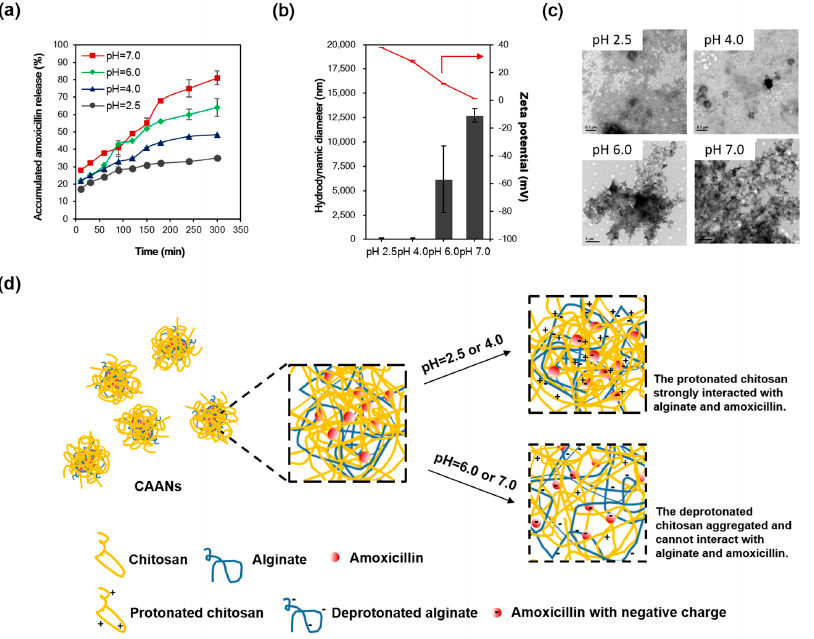
Figure 2. ( a ) The percent release profiles of the prepared CAANs at pH 2.5, 4.0, 6.0, and 7.0 and 37 °C. ( b ) Hydrodynamic diameter and zeta potential and ( c ) TEM images of the prepared CAANs at pH 2.5, 4.0, 6.0, and 7.0. ( d ) Schematic illustration of the amoxicillin release from the CAANs at pH 2.5, 4.0, 6.0, and 7.0 by decreasing the interaction of deprotonated chitosan with